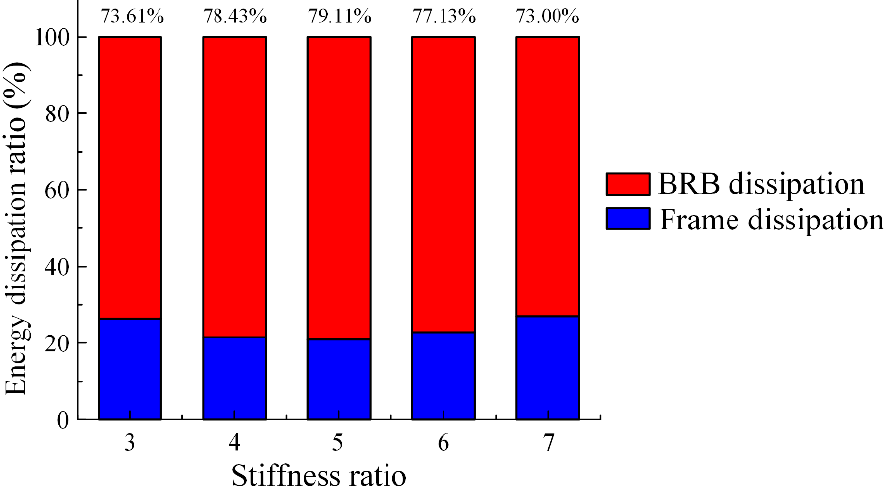
Figure 21. Change of the energy dissipation ratio of BRBs in the 12-story PCF-BRB